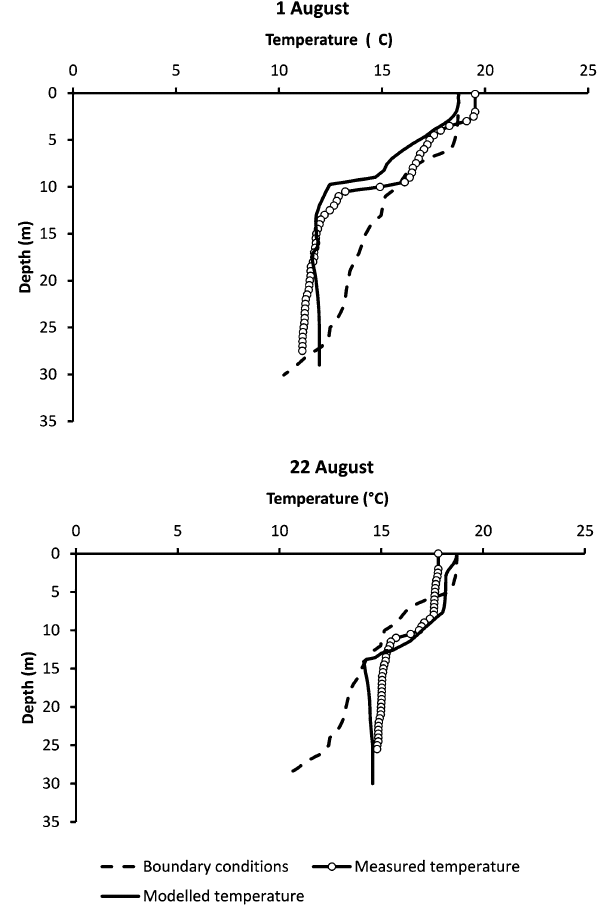
Fig. 4 Boundary conditions, and observed and modelled temperature profiles at the Lankiluoto deep on 1 August ( top ) and 22